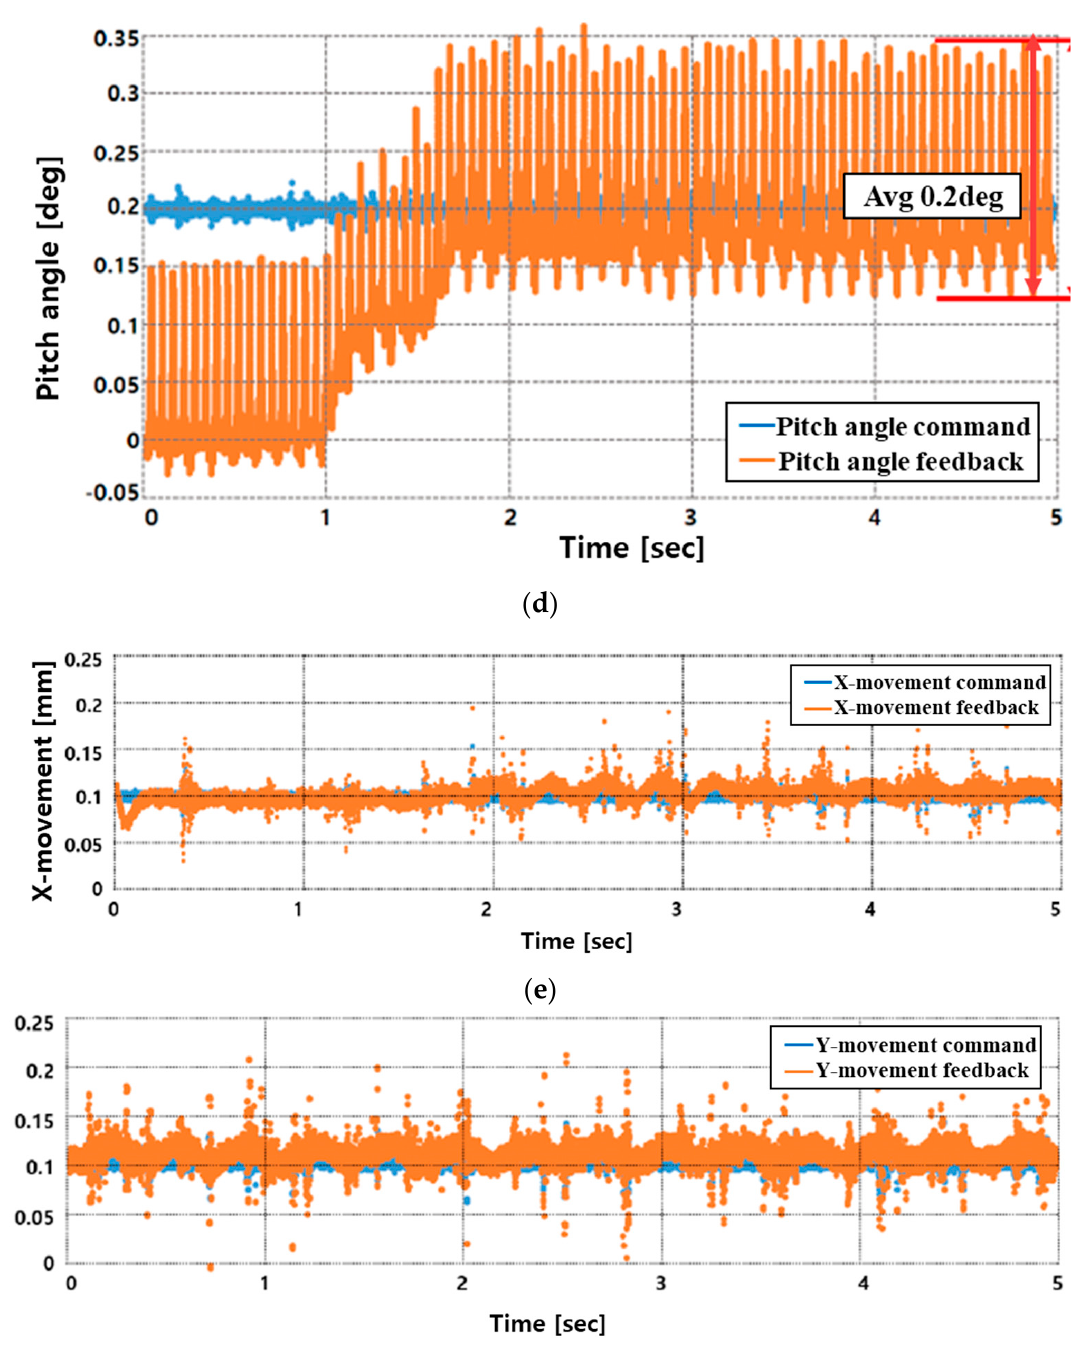
Figure 18. Results of the performance test using a prototype: ( a ) Rotation, ( b ) Levitation, ( c ) Roll, ( d ) pitch, ( e ) X-axis movement, ( f ) Y-axis movement.